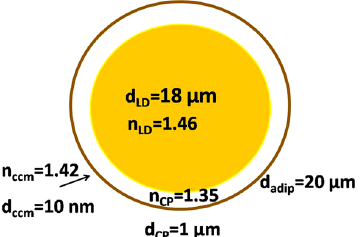
Figure 2. The adipocyte as an optical model: an optical model of adipocyte. CCM is the cell cytoplasmic membrane; CP is the cytoplasm; LD is the lipid droplet; adip is the